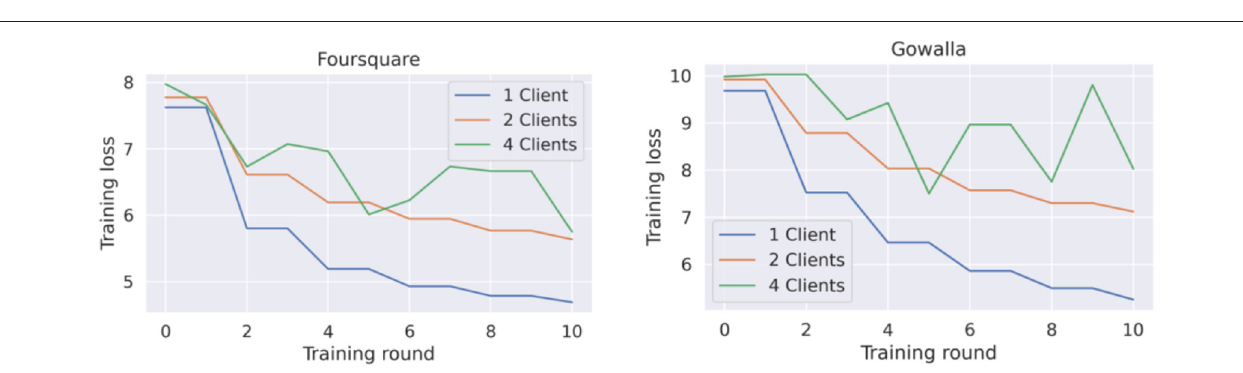
FIGURE 6 | Training loss for federated GRU-spatial model with 1, 2, and 4 clients.